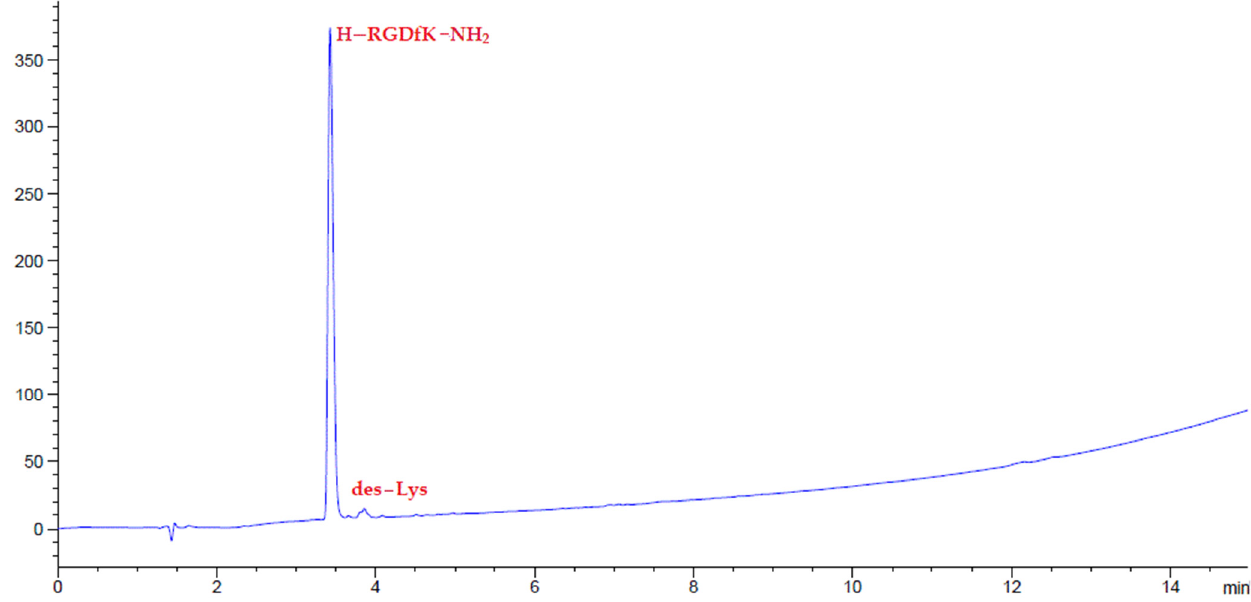
Figure 8. HPLC chromatograms of crude peptides H-RGDfK-NH 2 after precipitation.